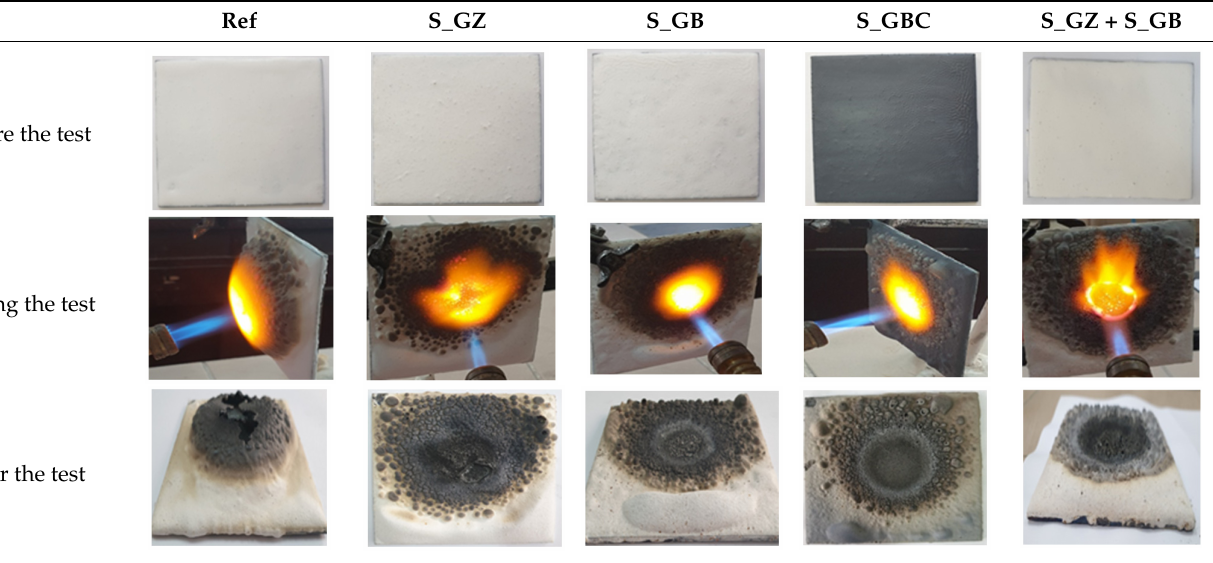
Table 3. Visual aspect of metal plates coated with intumescent silicate paints, before, during and after direct contact with the